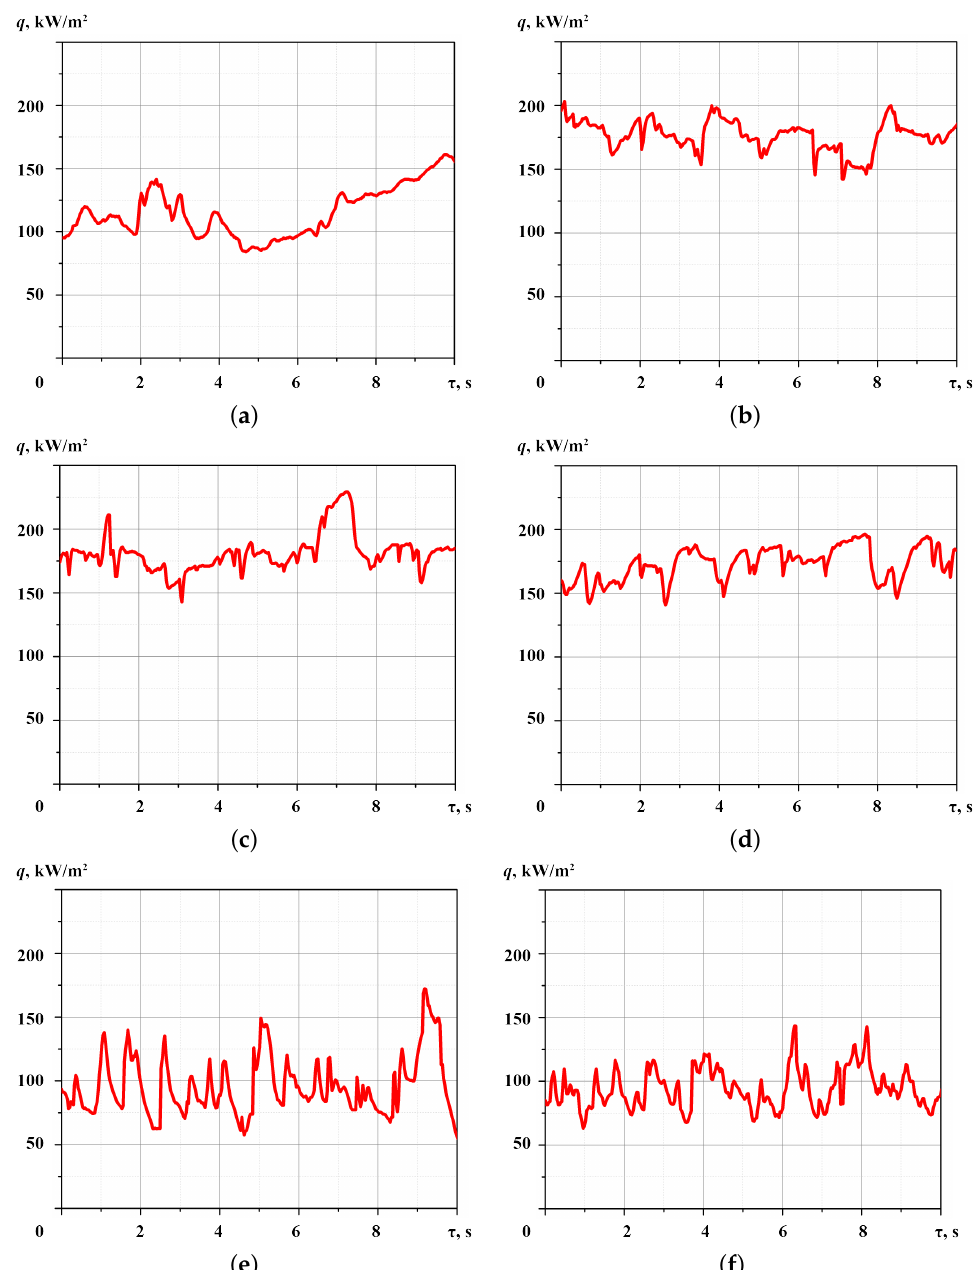
Figure 8. Time-dependent heat flux graph for saturated steam condensation on the horizontal pipe at the azimuthal angle ϕ of: ( a )—0 ◦ ; ( b )—45 ◦ ; ( c )—60 ◦ ; ( d )—75 ◦ ; ( e )—165 ◦ ; ( f )—180 ◦